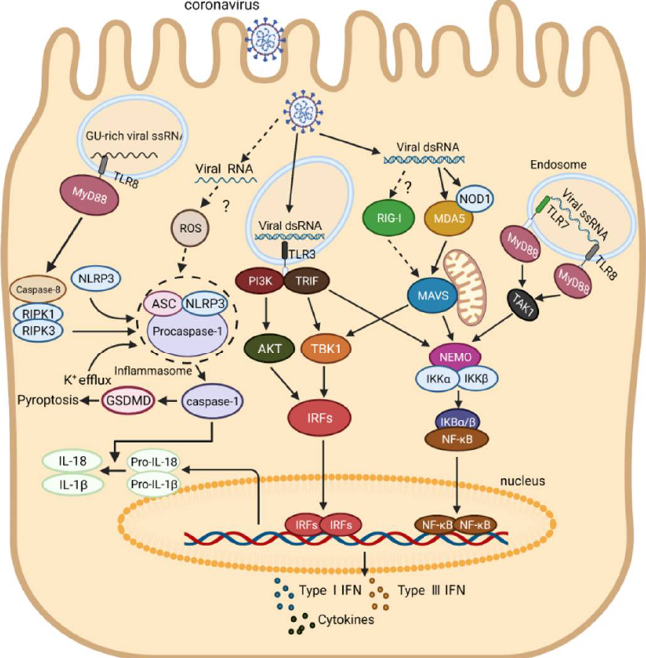
Figure 3. Schematic diagram of innate immune response induced by coronavirus RNA. Viral dsRNA is sensed by TLR3 in endosomes, triggering the innate immune response, while ssRNA in endosomes is sensed by TLR7/8 and induces the production of inflammatory cytokines through the MyD88-TAK1-IKK-NF- κ B signaling pathway. Viral dsRNA is recognized by MDA5 and NOD1, and then interacts with MAVS on mitochondria, which further activates the NF- κ B and IRFs signaling pathways. Viral GU-rich ssRNA is sensed by TLR8, causing the activation of NLRP3 inflammasomes through the Caspase-8-RIPK1 signaling pathway, leading to the secretion of mature IL-1 β and IL-18. Importantly, it is not clear whether viral dsRNA is recognized by RIG-I to initiate IFN response or whether viral RNA induces inflammasome formation; thus, the associated pathway is indicated by dotted lines. Abbreviation: RIPK, Receptor interacting protein kinase; other abbreviations are shown in the legend to Figure 2.